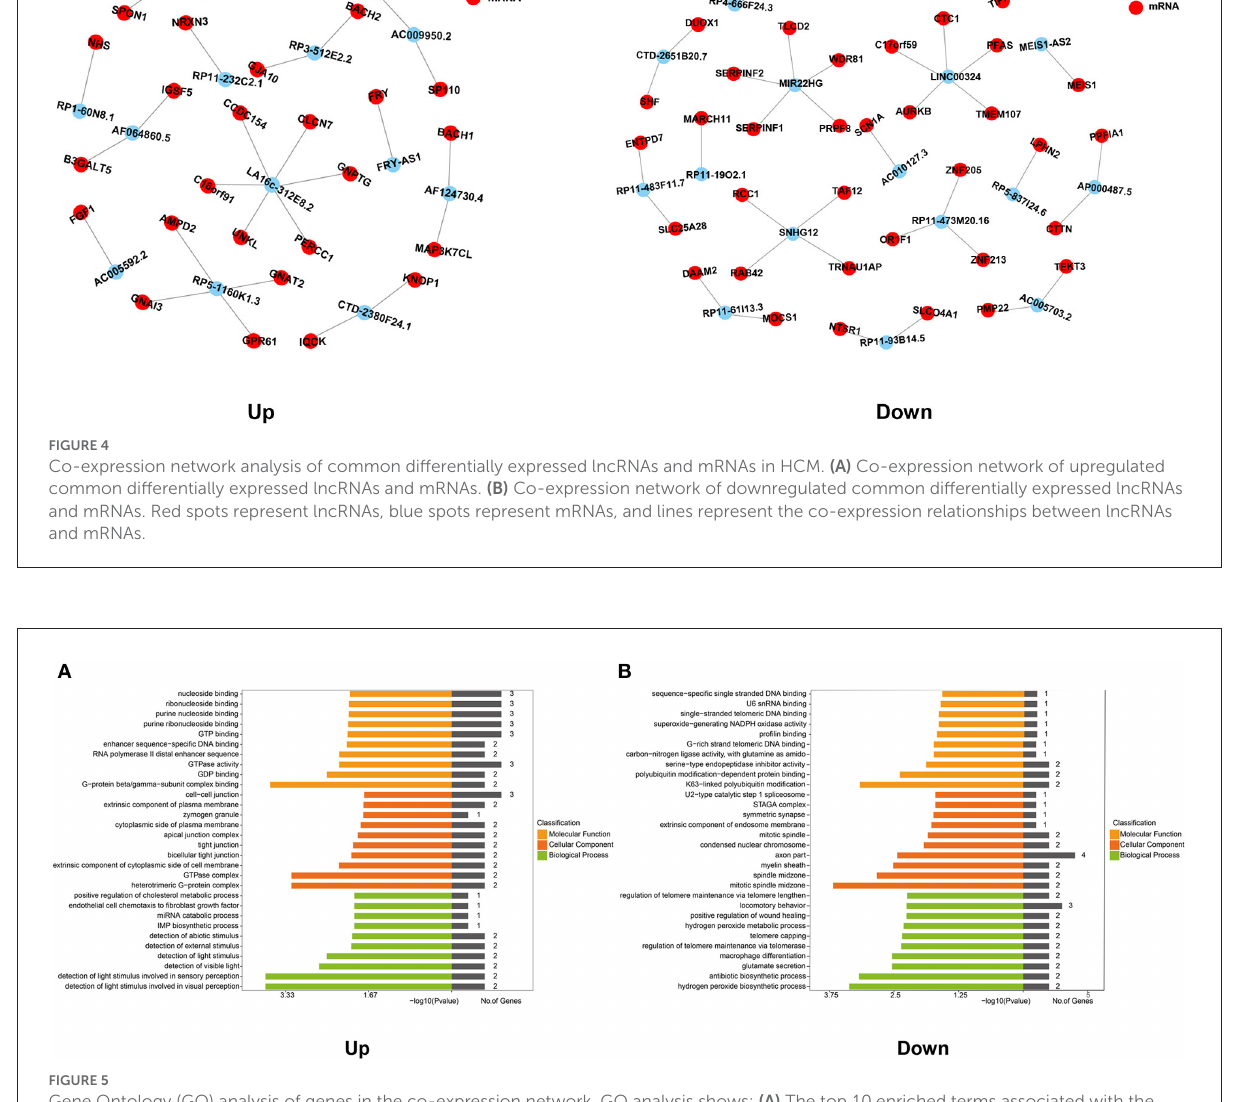
HCM prompts that three key lncRNAs